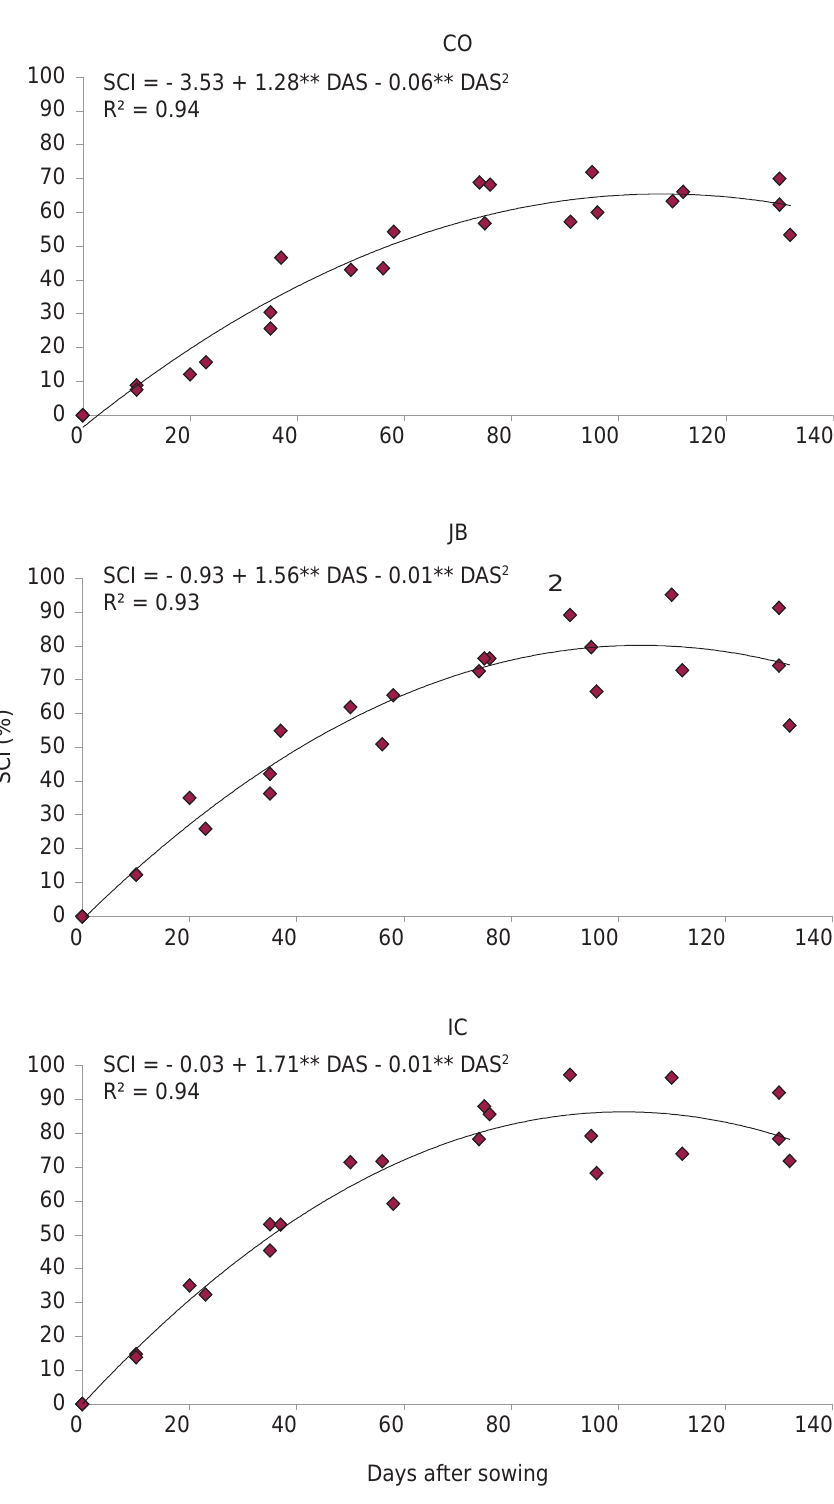
Figure 1. Soil cover index (SCI) of different crop systems in three crop seasons in a Typic Hapludox. CO: corn only; JB: jack bean only; IC: corn intercropped with jack